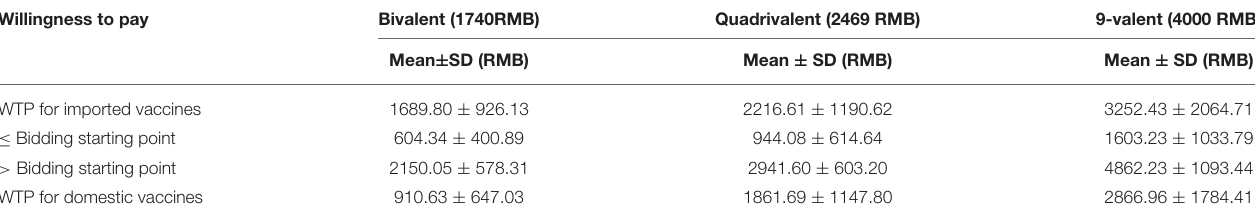
TABLE 4 | WTP for imported and domestic HPV vaccines, full dose.